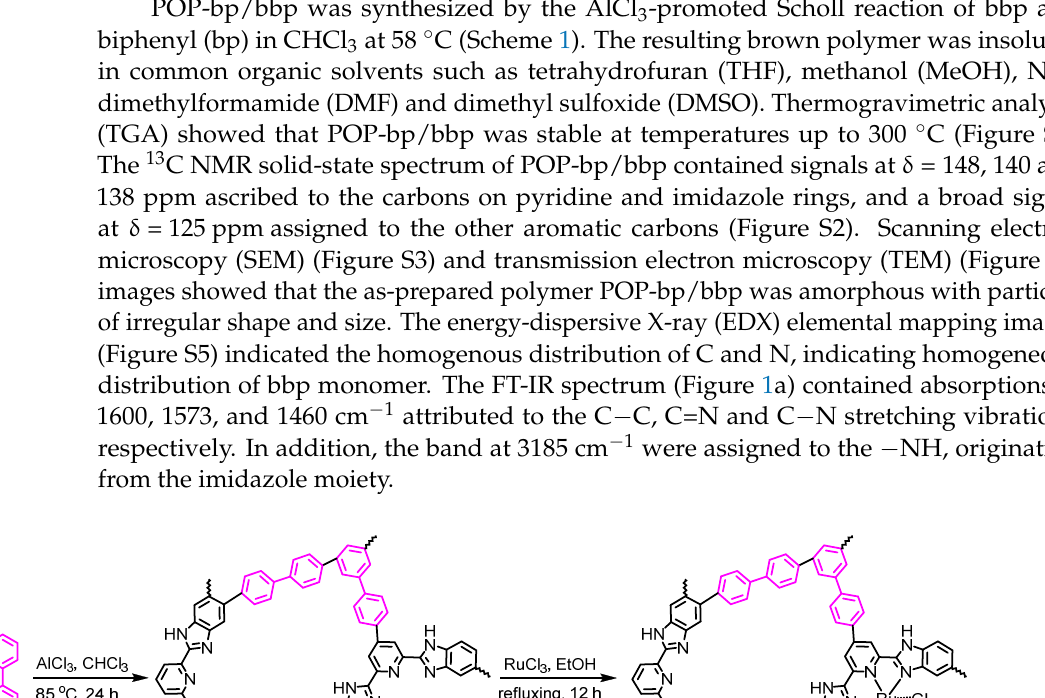
Figure 1. ( a ) Fourier transform infrared (FT-IR) spectra of POP-bp/bbp and POP-bp/bbpRuCl 3 . ( b ) N 2 sorption isotherm for POP-bp/bbp and POP-bp/bbpRuCl 3 at 77 K. ( c ) N1s X-ray photoelectron spectroscopy (XPS) spectra of POP-bp/bbp and POP-bp/bbpRuCl 3 . ( d ) Ru 3p XPS spectra of POP- bp/bbpRuCl 3 . ( e ) High-resolution transmission electron microscopy (HR-TEM) image of POP- bp/bbpRuCl 3 . ( f ) Energy-dispersive X-ray spectroscopy elemental mapping of POP-bp/bbpRuCl 3 . POP-bp/bbp bearing NNN pincer groups was treated with RuCl 3 ·xH 2 O in refluxing EtOH under N 2 for 12 h to give Ru-metalated POP-bp/bbp (POP-bp/bbpRuCl 3 ). The po- rosity of POP-bp/bbp and POP-bp/bbpRuCl 3 was assessed by N 2 adsorption and desorp- tion analyses at 77.3 K. Absorption isotherms (Figure 1b) exhibited a type I adsorption isotherm with steep N 2 uptake at low relative pressure (P/P 0 < 0.1), indicating abundant micropores in the polymer structure. A slight hysteresis loop with a small rise in N 2 uptake at higher pressures was attributed to the presence of mesopores. The Brunauer − Em- me tt− Teller (BET) surface areas of POP-bp/bbp and POP-bp/bbpRuCl 3 were calculated to be 632 and 602 m 2 g − 1 , respectively. The pore-size distribution of POP-bp/bbp and POP- bp/bbpRuCl 3 were estimated with the aid of non-local density functional theory modeling to be centered around 6 − 10 Å (Figure S7). Inductively coupled plasma optical emission spectrometry (ICP-OES) of POP-bp/bbpRuCl 3 indicated 3.11 wt % Ru loading. The pow- der X-ray diffraction (PXRD) patterns confirmed that both the polymer and POP- bp/bbpRuCl 3 were amorphous (Figure S8). Ruthenium ion interaction with the NNN pincer moieties were observed by XPS (Fig- ures S9 and S10). Coordination of Ru(III) ions with POP-bp/bbp significantly changes the electron density at the pyridinic N sites and thus the binding energies of their N 1s elec- trons. The N 1s XPS profile of POP-bp/bbp was deconvoluted into two peaks centered at 398.84 and 400.47 eV, which are assigned to pyridinic N and imidazolic N, respectively (Figure 1c). After the loading of RuCl 3 , a new N 1s XPS peak was observed at 399.71 eV,